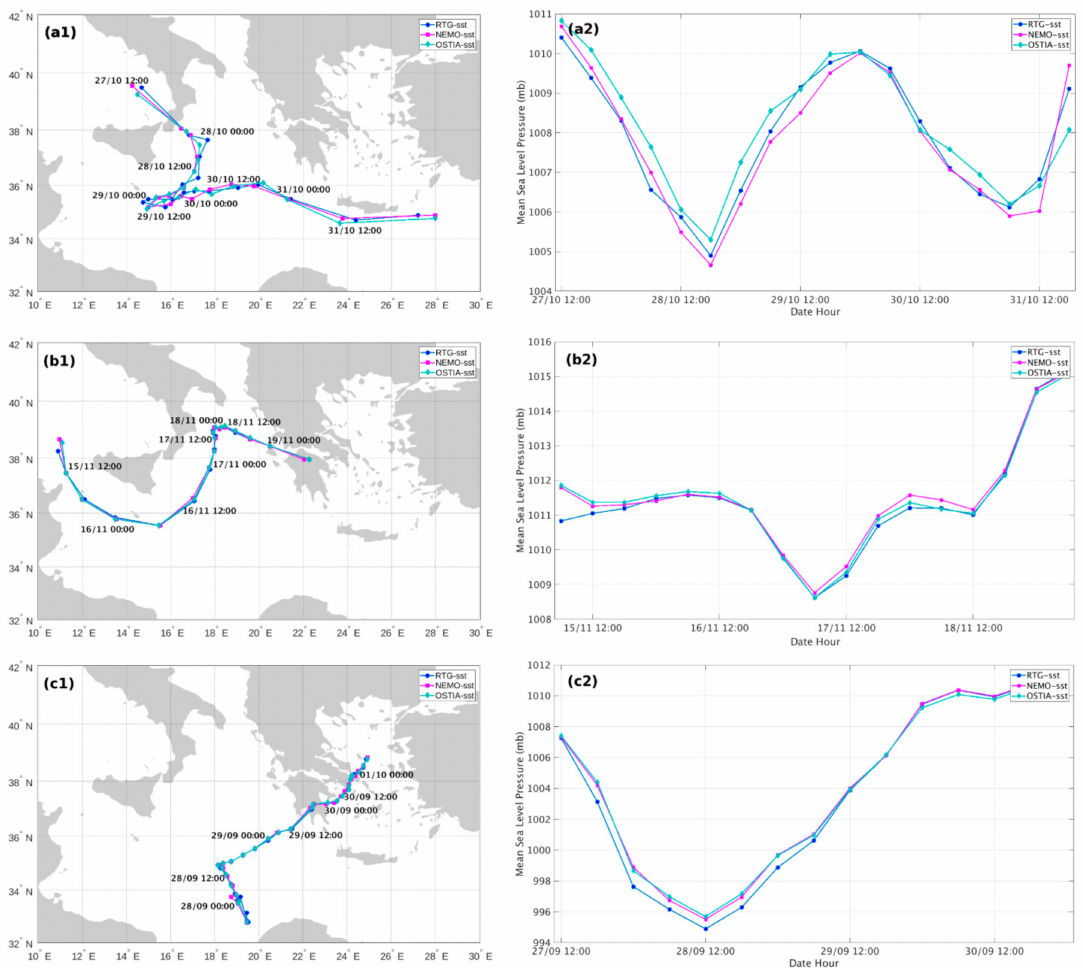
Figure 8. Storm tracks from RTG-sst, NEMO-sst, and OSTIA-sst simulations represented by the MSLP in six-hour intervals and MSLP evolution for ( a1 – 2 ) cyclone Trixi, ( b1 – 2 ) cyclone Numa, and ( c1 – 2 ) cyclone